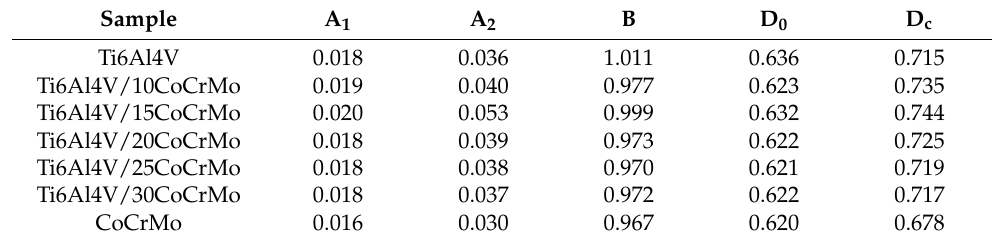
Figure 4. Compressibility of powder mixtures in close die pressing: ( a ) evolution of relative density as a function of applied pressure and ( b ) densification ((D-D 0 )/D 0 ) obtained by compaction. Table 2. Density–pressure liner curve fitting parameters for Ti6Al4V and composite samples.